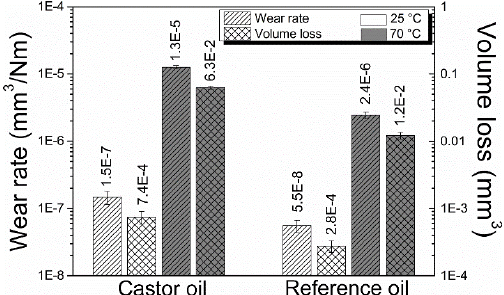
Figure 7. Wear rate and Volume loss of AISI 4140 vs. WC lubricated with Castor and Reference oil at 25 and 70 °C ( Y -axis in logarithmic scale).